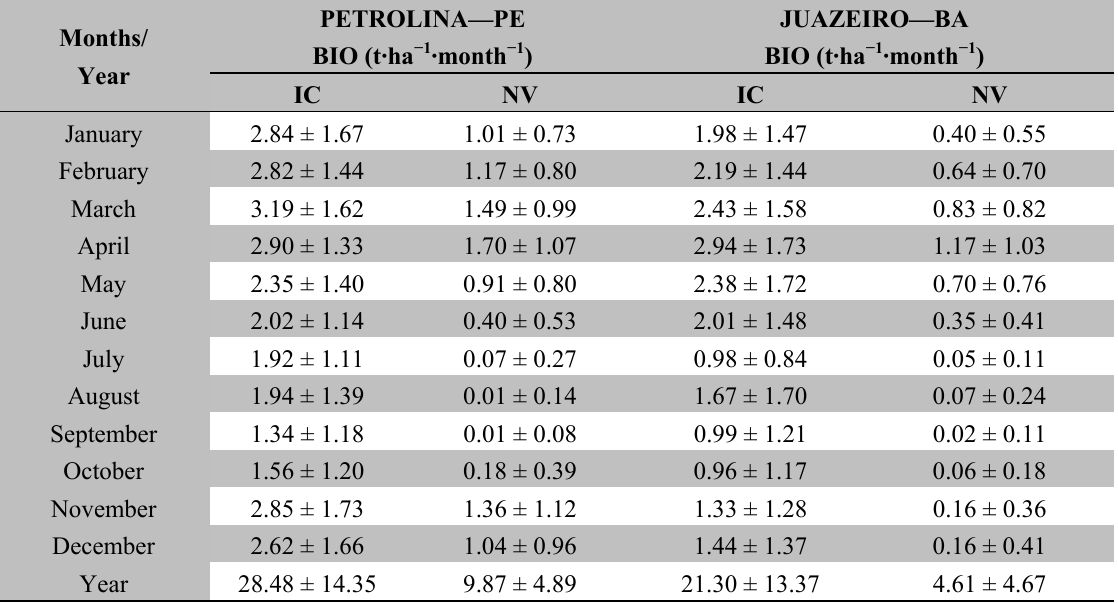
Table 2. Monthly average values and standard deviations (SD) of biomass production (BIO) from irrigated crops (IC) and natural vegetation (NV) in Petrolina and Juazeiro municipalities, respectively Pernambuco (PE) and Bahia (BA) states, Brazil, during the year of